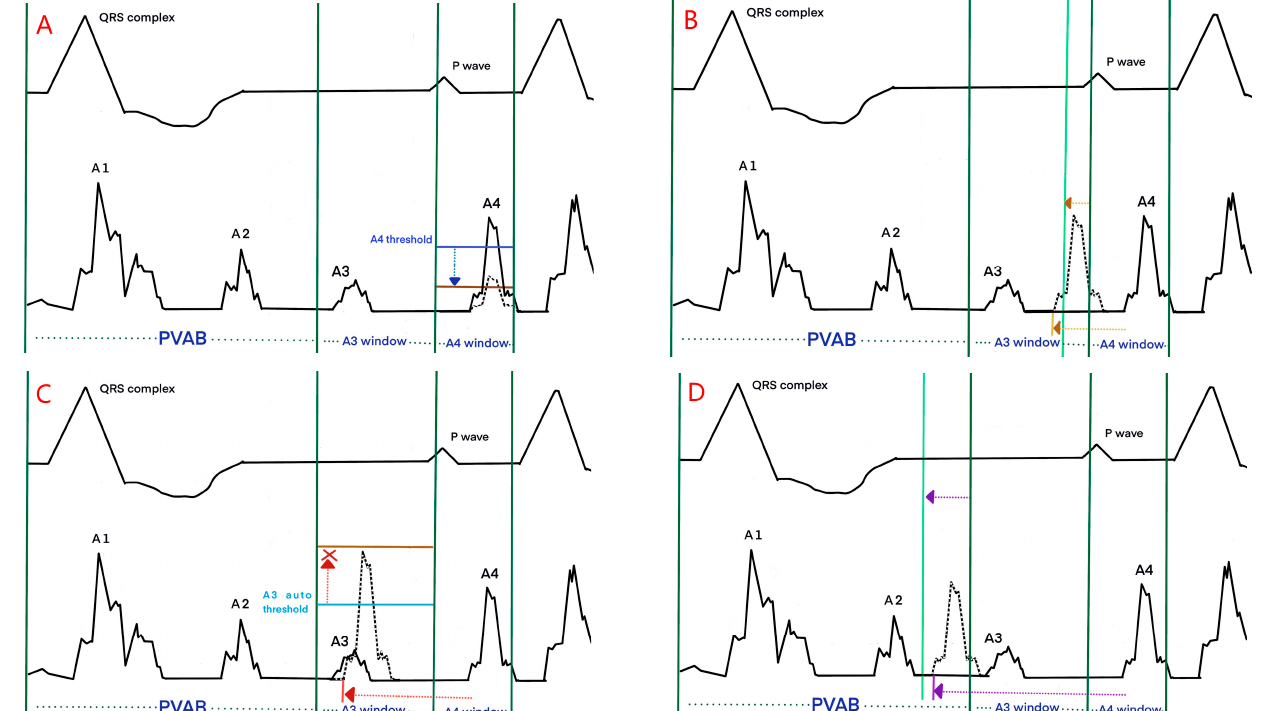
Figure 3. Schematic illustration and device programming in various situations. The blue dotted line indicates a lower A4 threshold in the situation of low A4 amplitude ( A ). The yellow dotted line indicates a shorter A3 window end interval in the situation of the A4 signal falling in the A3 window ( B ). The red dotted line indicates the deactivation of the A3 auto threshold function in the situation of the A4 signal merging with the A3 signal ( C ). The purple dotted line indicates a shorter PVAB in the situation of the A4 signal falling in the PVAB period ( D ).